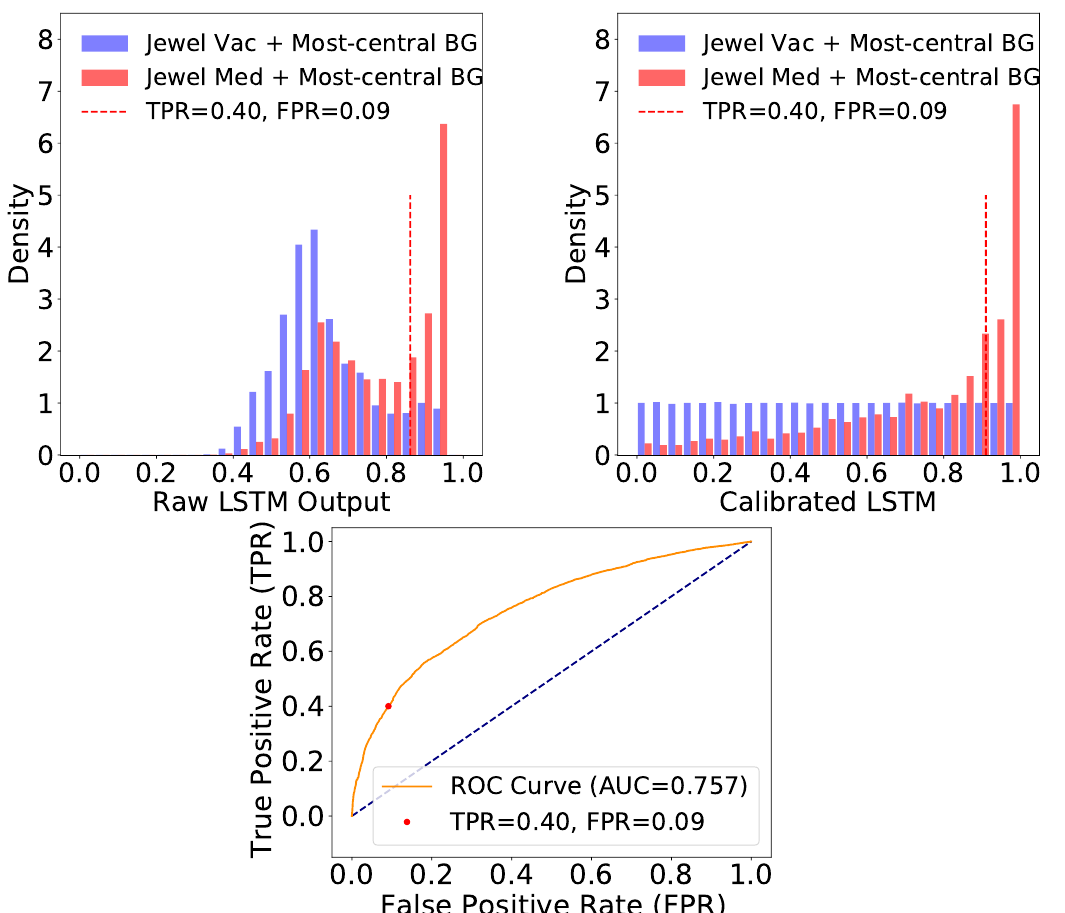
Figure 13 . Distributions of the raw LSTM output (upper left), their calibrated values (upper right) and the corresponding ROC curve